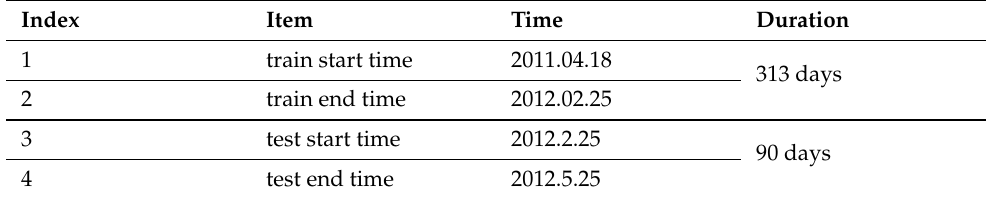
Table 2. Experiment case for REDD datasets.